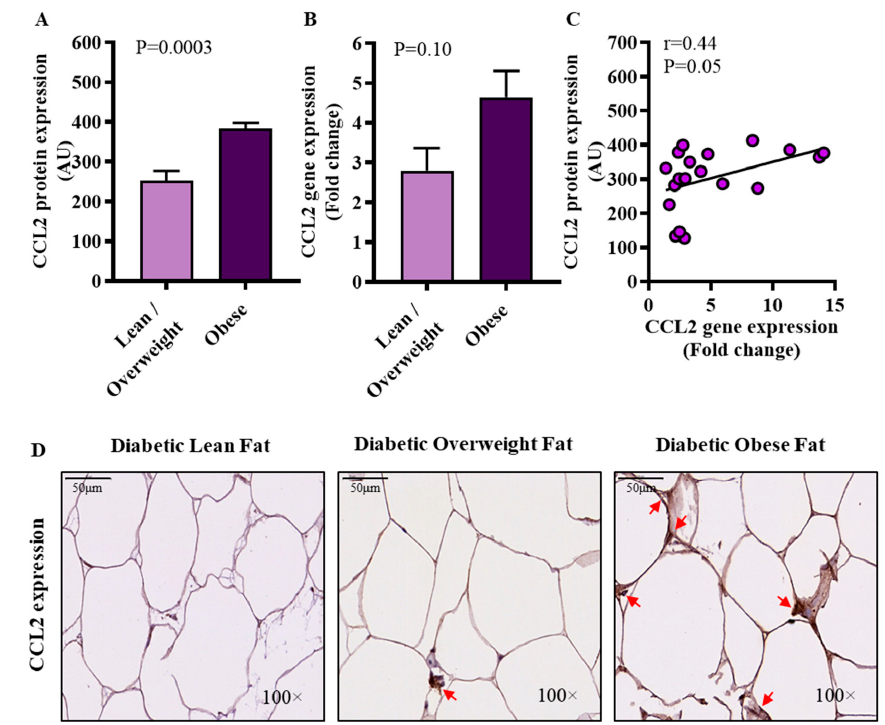
Figure 5. Increased adipose CCL2 protein expression in diabetic obese patients. Adipose CCL2 protein and gene expressions were determined by immunohistochemistry (IHC) and qRT-PCR in 21 and 46 type-2 diabetic patients, respectively, as described in materials and methods. Regarding IHC, CCL2 protein staining intensity expressed as arbitrary units (AU) was determined by using Aperio-positive pixel count algorithm and ImageScope software. The number of positive pixels was normalized to total pixels (positive and negative) and color / intensity thresholds were set with immunostaining as positive and background as negative pixels. Regarding qRT-PCR, GAPDH gene expression was used as internal control. The expression level of CCL2 gene relative to control (lean adipose tissue) was calculated by using 2 − ∆∆ Ct method and expressed as relative mRNA expression or fold change over the average control expression taken as 1. ( A ) The data (mean ± SEM) show that CCL2 protein expression (AU) was significantly higher in diabetic obese patients compared to diabetic lean / overweight patients ( p = 0.0003). ( B ) However, CCL2 transcripts (fold change) di ff ered non-significantly between diabetic obese and diabetic lean / overweight patients ( p = 0.10). ( C ) CCL2 gene and protein expressions correlated positively ( r = 0.44, p = 0.05). ( D ) The representative IHC images from three independent determinations with similar results show the comparative adipose CCL2 protein expression (arrows) in diabetic lean, overweight, and obese patients (100 × magnification; scale bar 50 µ